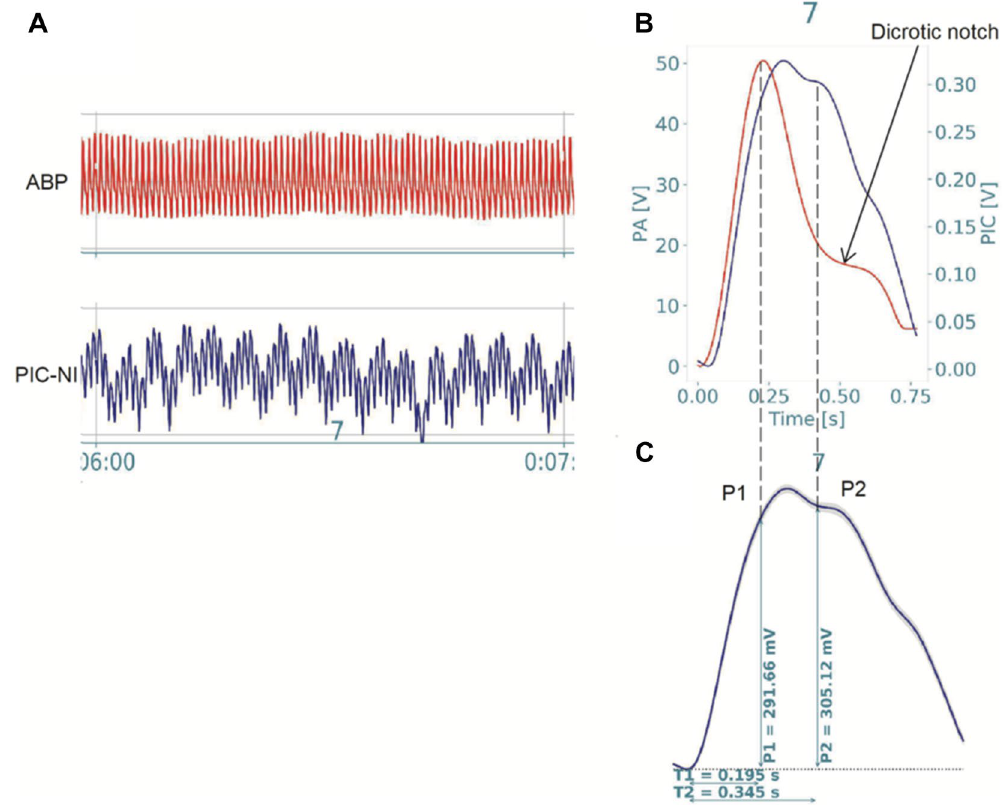
Figure 3. Illustration from a representative migraine patient. ( A ) Arterial blood pressure (ABP) and noninvasive intracranial pressure (ICP-NI) from minute seven of data collection. ( B,C ) Mean pulse of ABP and ICP-NI synchronized data illustrating the arterial blood pression maximum and the dicrotic notch and the P1 and P2 corresponding values and